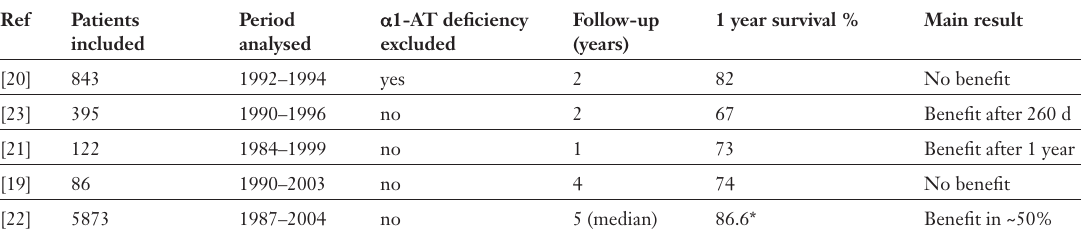
Published studies on the survival benefit after lung transplan- tation for